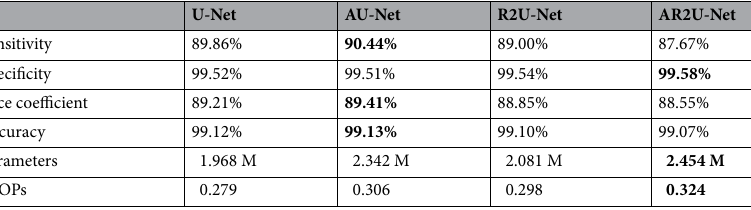
Table 1. Average sensitivity, specificity, dice coefficient, accuracy, parameter count, FLOP, of U-Net, attention U-Net and residual U-Net models. Bolded numbers represent the largest value in that category. M in parameters represents million.